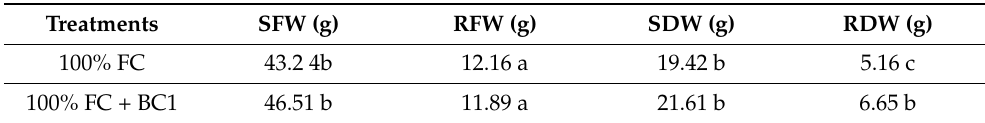
Table 2. The hazardous effects of drought on morphological attributes of Leptocohloa fusca and its mitigation by biochar